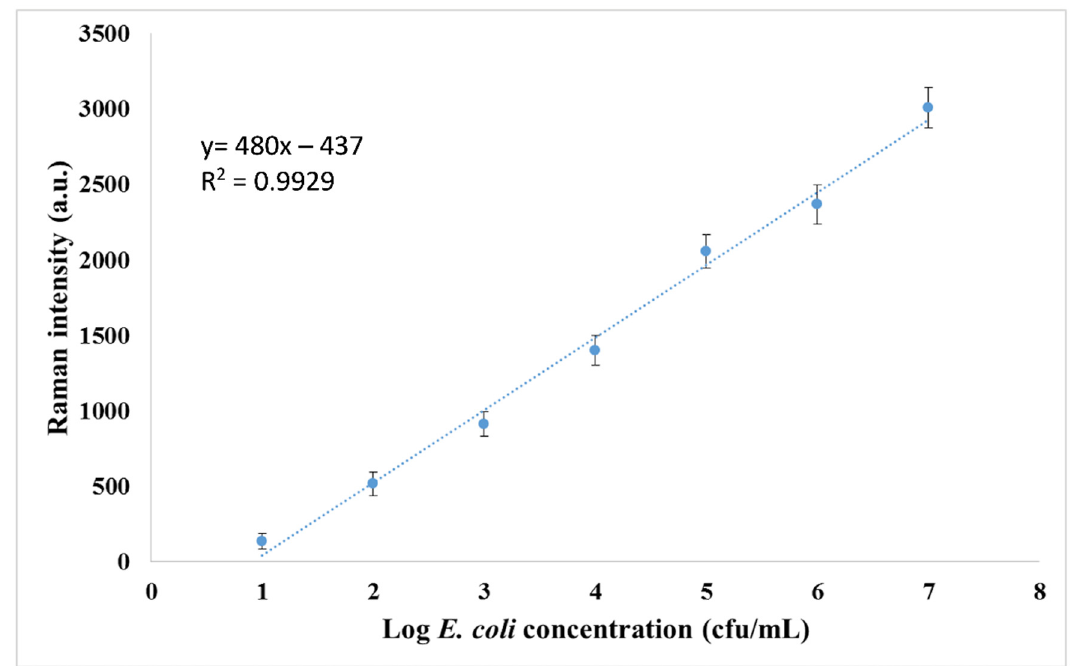
Figure 6. Calibration curve obtained for E. coli .